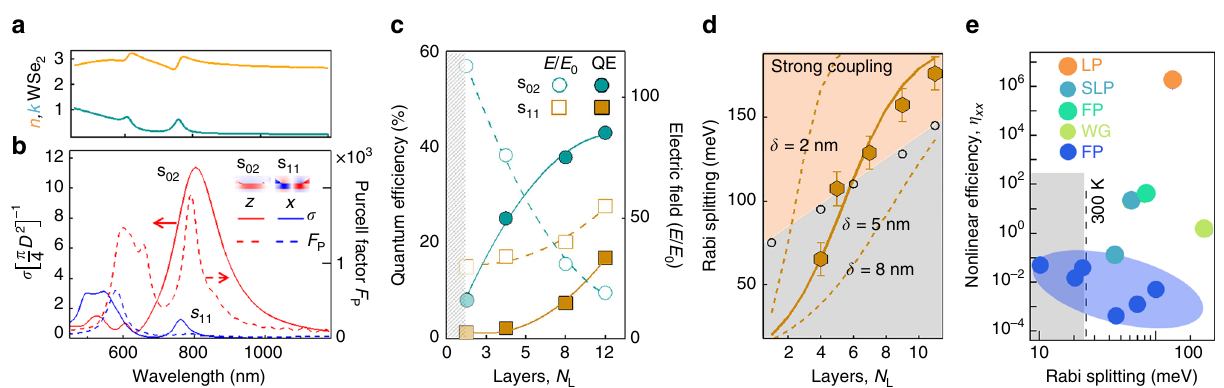
Fig. 4 Comparison of calculated Purcell and pumping factors. a Effective refractive index n + ik of multilayer WSe 2 . b FDTD simulations of the scattering cross section (solid lines) and Purcell factors (dashed) for optical fi elds along normal ( z ) and in-plane ( x ) directions. c Quantum ef fi ciency (solid lines) and fi eld enhancement (dashed) vs. number of monolayers, when keeping s 02 , s 11 tuned to A exciton by changing the NP diameter (Supplementary Fig. 9). d Rabi splitting for NPoMs containing different numbers of WSe 2 layers, with fi t to model (orange line, see text) depending on exciton interlayer coupling length δ . Error bars originate from the variation in the dark- fi eld scattering and are extracted from the standard error of the fi t. Grey circles are obtained from measured plasmon linewidths (NPoM size changed to retain exciton resonance), the strong-coupling regime is shaded orange. e Comparison of strong coupling Rabi splittings and exciton nonlinear ef fi ciencies for different cavities: localised plasmon (LP, present work), surface lattice plasmons (SLP), Fabry – Perot mirror cavities (FP, blue = monolayer, green = multilayer), waveguide (WG) (for references see Supplementary Table